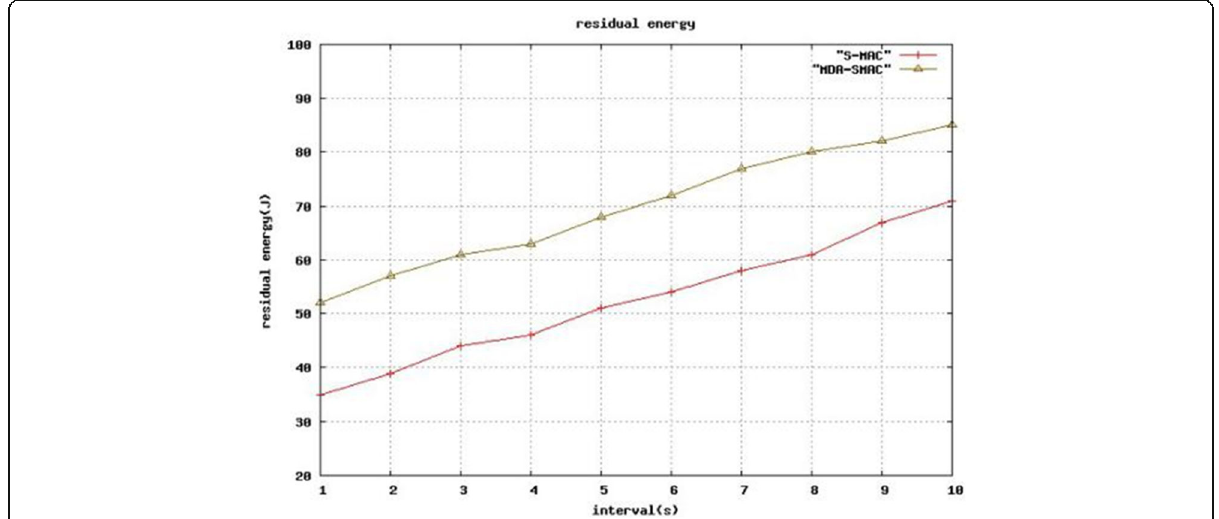
Fig. 9 The comparison of residual energy of nodes